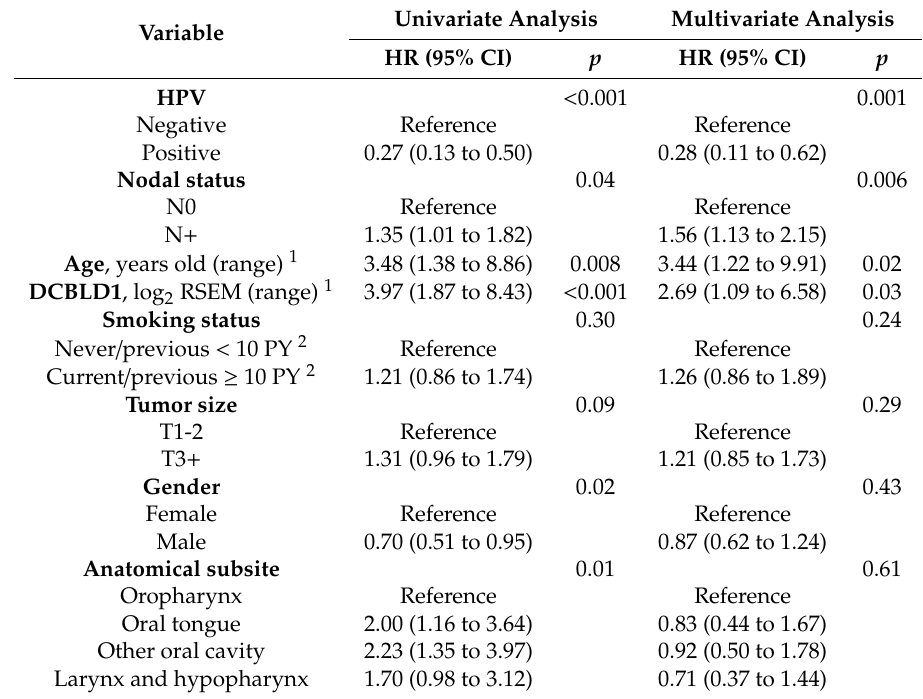
Table 3. Multivariate Cox proportional hazards analysis of overall survival in the TCGA HNSCC cohort. Univariate Variable